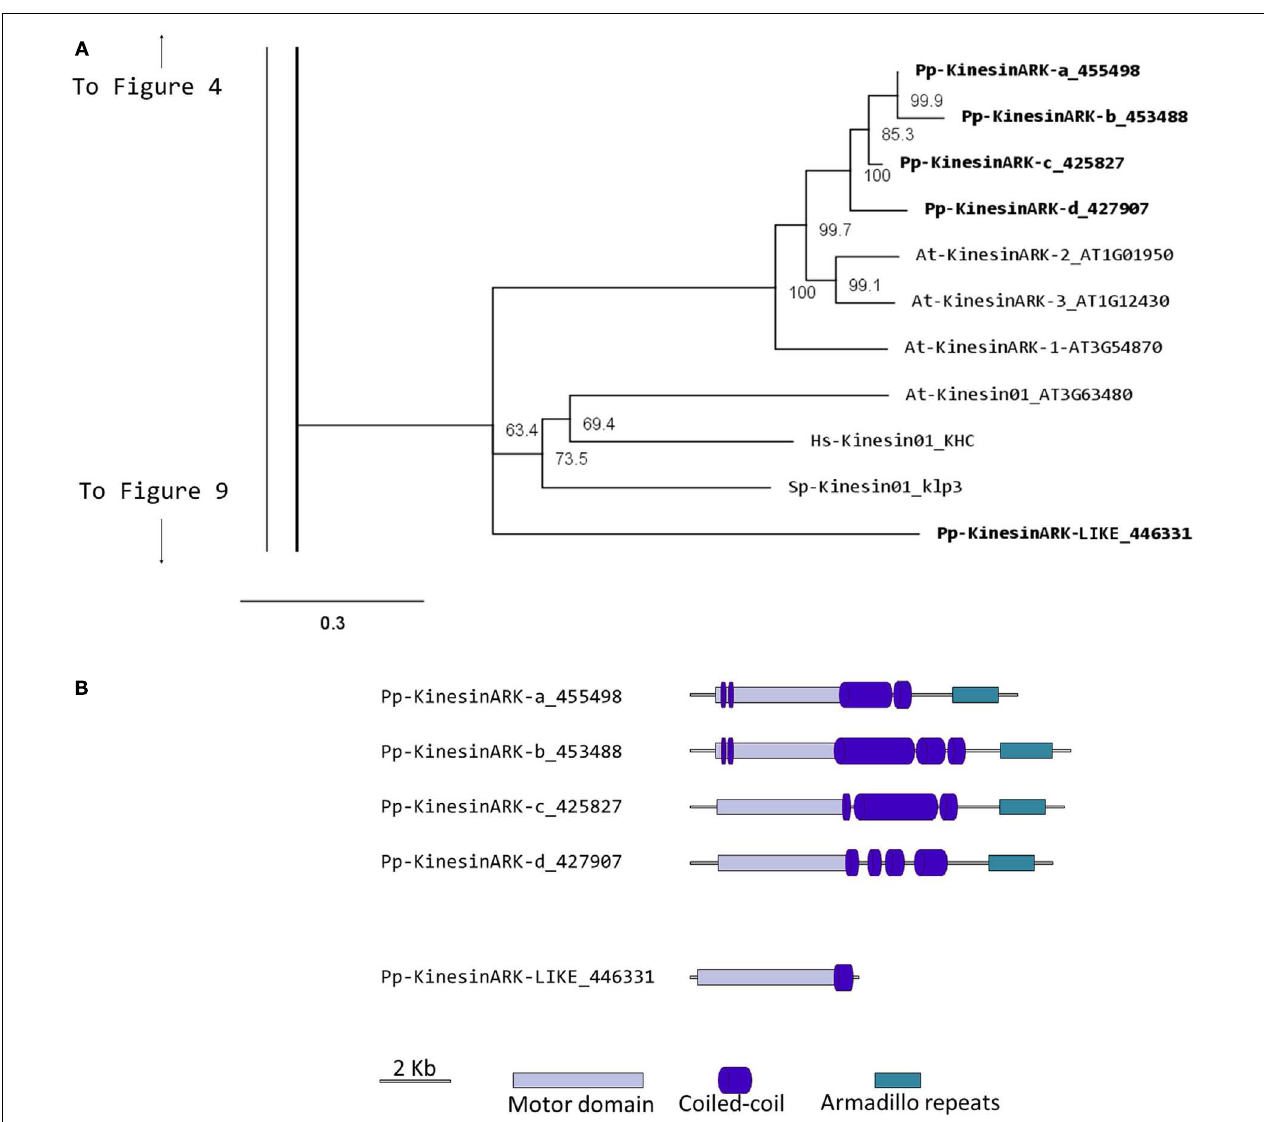
site.The Physcomitrella numbers correspond to the Phypa number uniquely associated with each gene model (version 1.6) at cosmoss.org. (B) Gene models of kinesin 1s and ARKs. Schematic diagrams showing the structure and domain architecture of kinesin 1s and armadillo repeat containing kinesins (ARKs). Domains are indicated at the bottom of the diagrams. Armadillo repeats are comprised of a repeating sequence of forty-two amino acids that can form helices which upon repetition form a right handed super